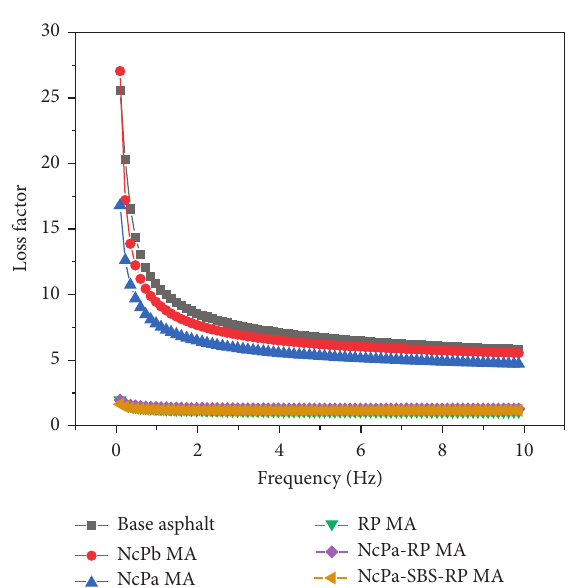
Figure 9: Complex shear modulus versus frequency.